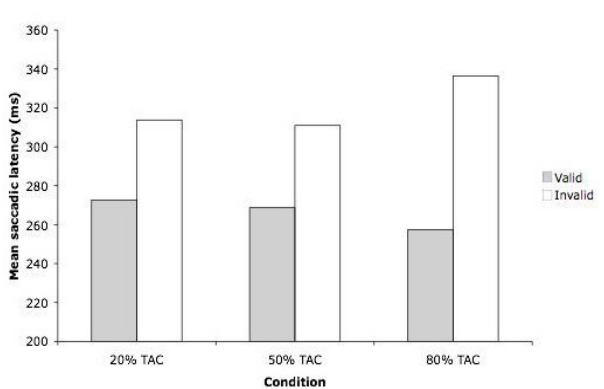
Figure 2: Results from Experiment 1, showing mean saccadic latency (in milliseconds) for valid and invalid trials, across the three conditions. TAC = Target at